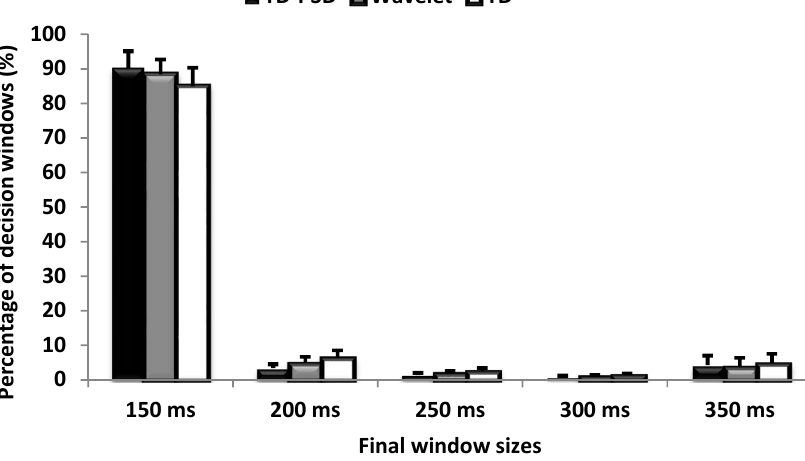
Figure 5. Average percentages for each of the window sizes for the case of nine movements with 7 EMG channels with 3 feature extraction methods (TD-PSD, Wavelets and TD) and the proposed adaptive windowing framework. Error bars represent SD across nine amputees .